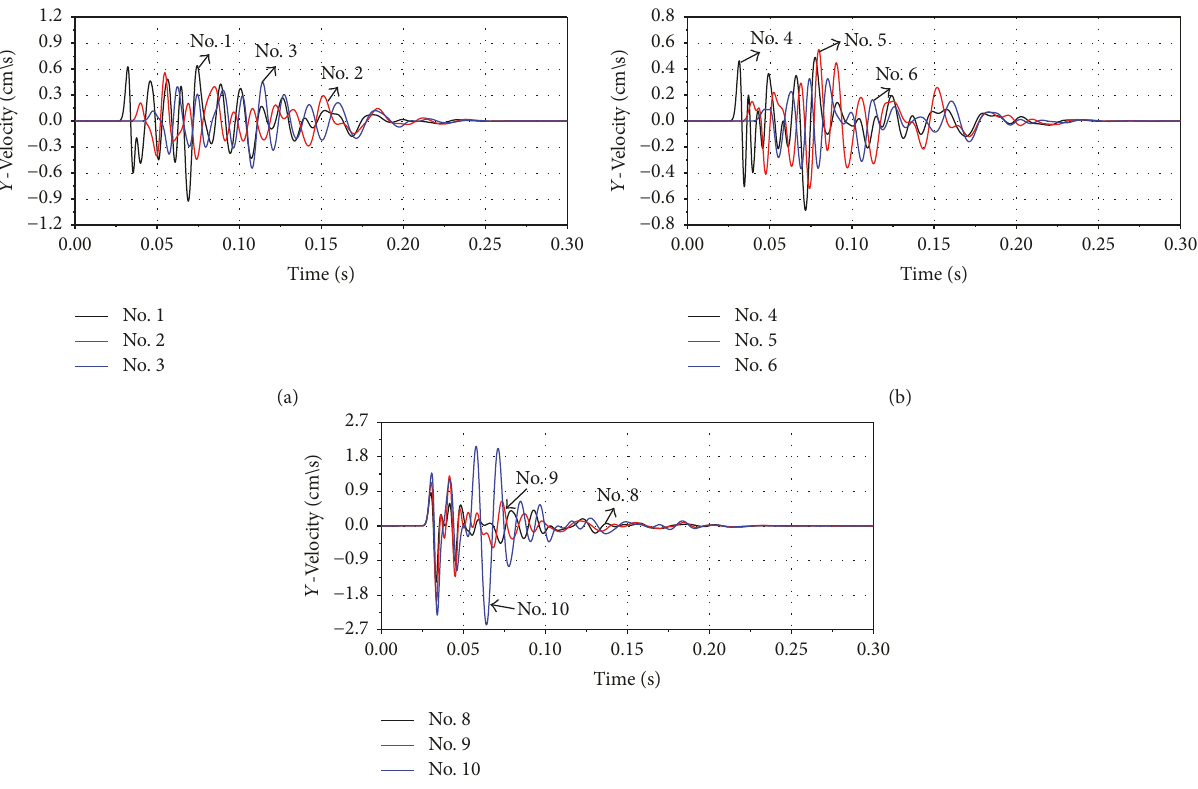
Figure 10: Axial velocity in draw cut blasting of deep hole: (a) axial velocity of generator layer in draw cut blasting of deep hole; (b) axial velocity of turbine layers in draw cut blasting of deep hole; (c) axial velocity of different elevation for 6# generator sets in draw cut blasting of deep hole.